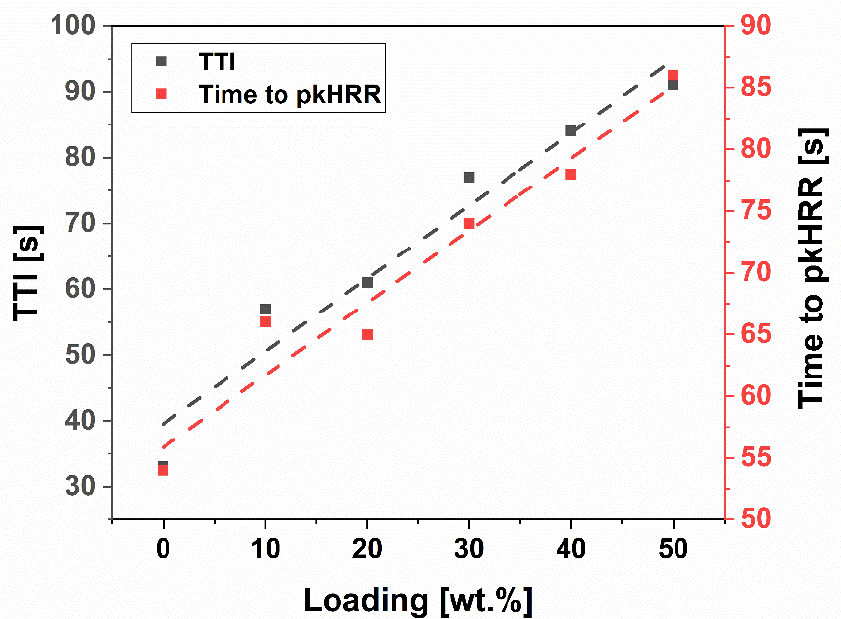
Figure 5. Time to Ignition and Time to peak of Heat Release Rate as a function of the glass phosphate powder loading. The square symbols are experimental values, while the dashed lines are linear fitting curves.